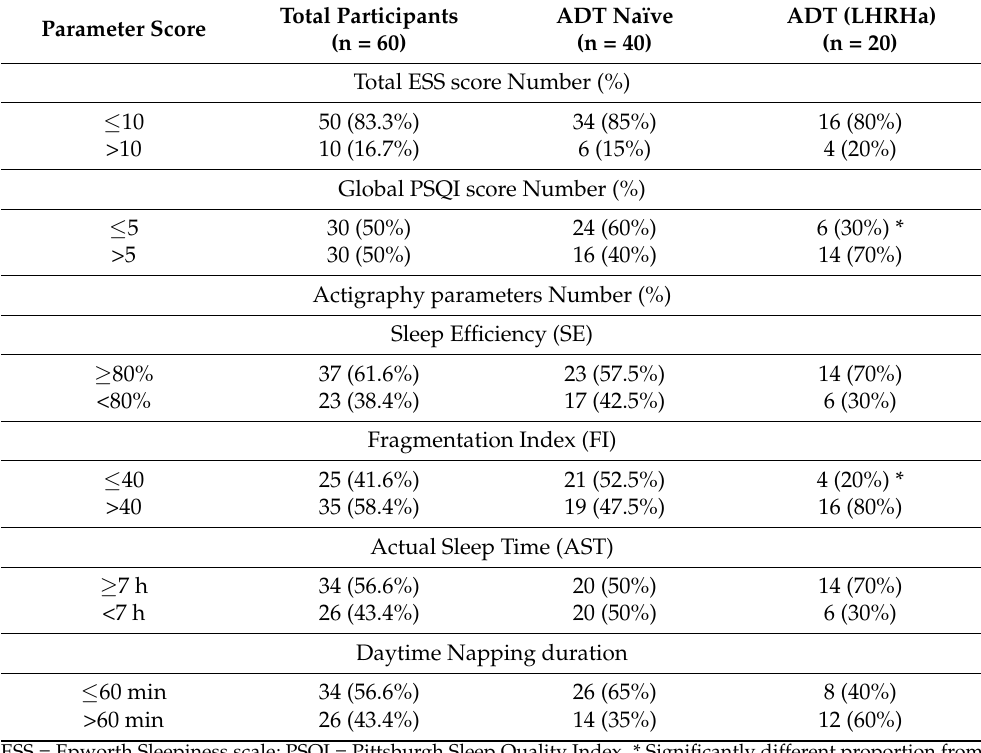
Table 2. Prevalence data for study cohort—The accepted abnormal values for each parameter are highlighted in bold